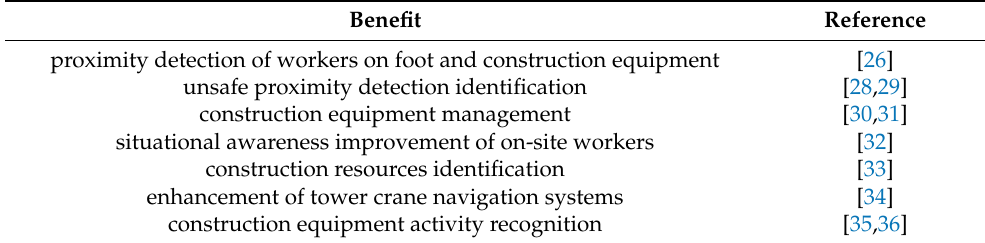
Table 1. GPS technology in construction safety